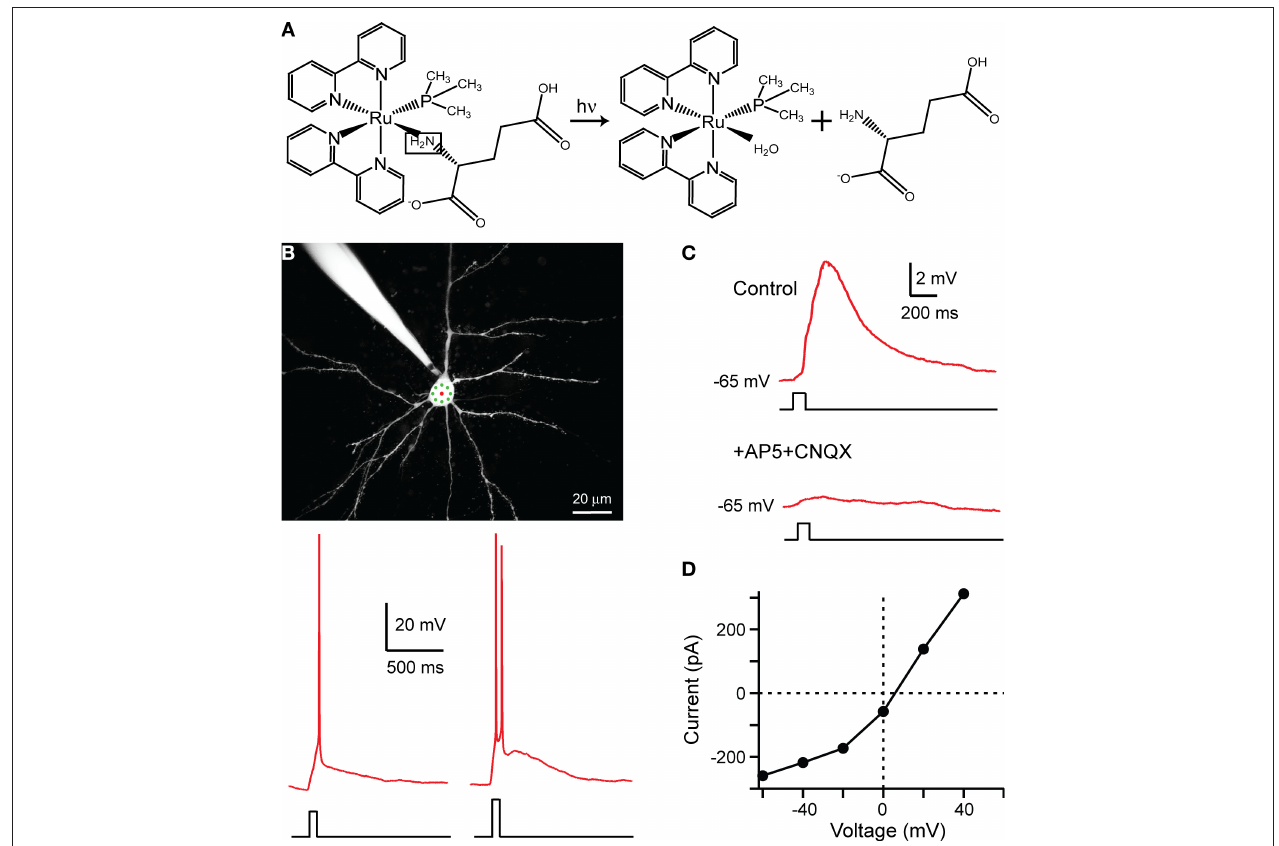
FIGURE 1 | RuBi-Glutamate uncaging activates glutamate receptors. (A) Structure of Ruthenium-bipyridine-trimethylphosphine-Glutamate (RuBi- Glutamate) and glutamate photorelease reaction. (B) Upper panel: Layer 2/3 pyramidal cell loaded with Alexa-594 and position of the multiplexed uncaging laser targets (eight subtargets) on the soma of the cell. Lower panel: Action potentials triggered by uncaging of RuBi-Glutamate (300 µM) in a layer